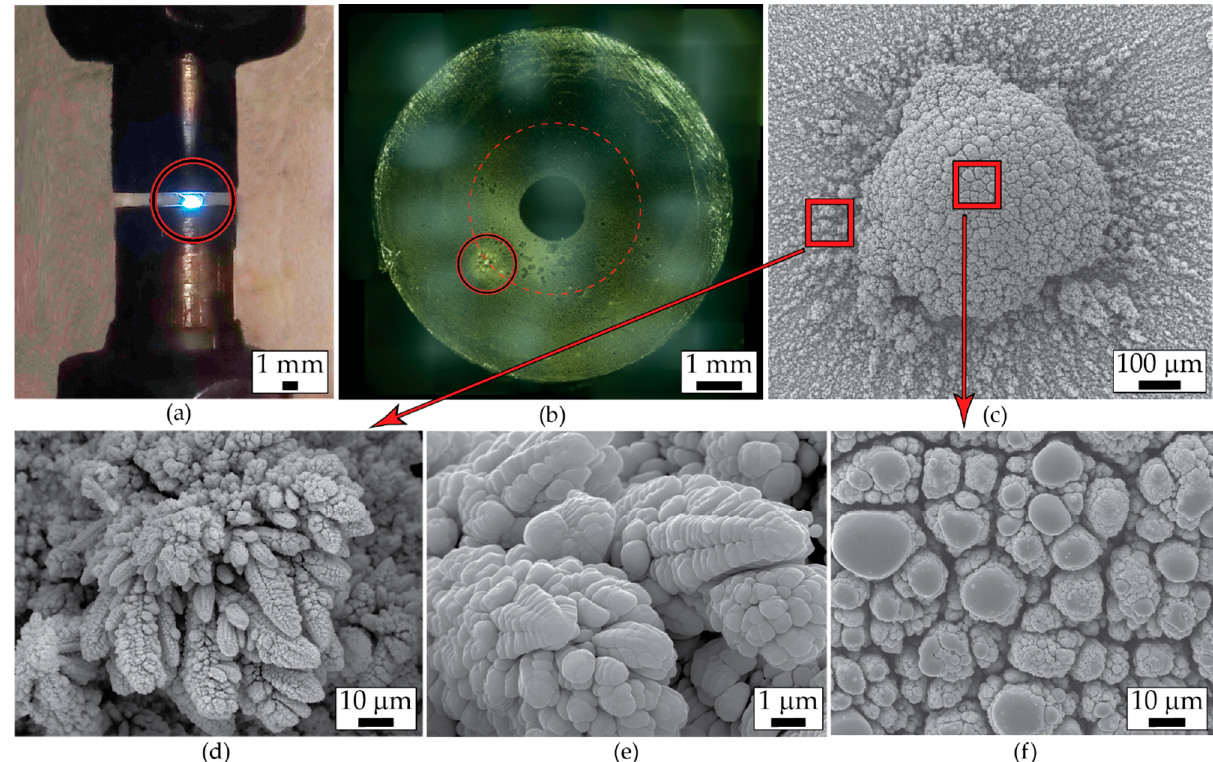
Figure 12. ( a ) Photo of the SD localization in the spark gap at the point of growth of the protrusion from the anode; ( b ) Optical microscope image of the anode end face with the designation of micro-protrusions formation area (dashed circle) and the dominant protrusion (solid circle); ( c – f ) SEM images of characteristic parts of the growing protrusion microstructure. Subfigure ( e ) is a magnified part of subfigure ( d ).